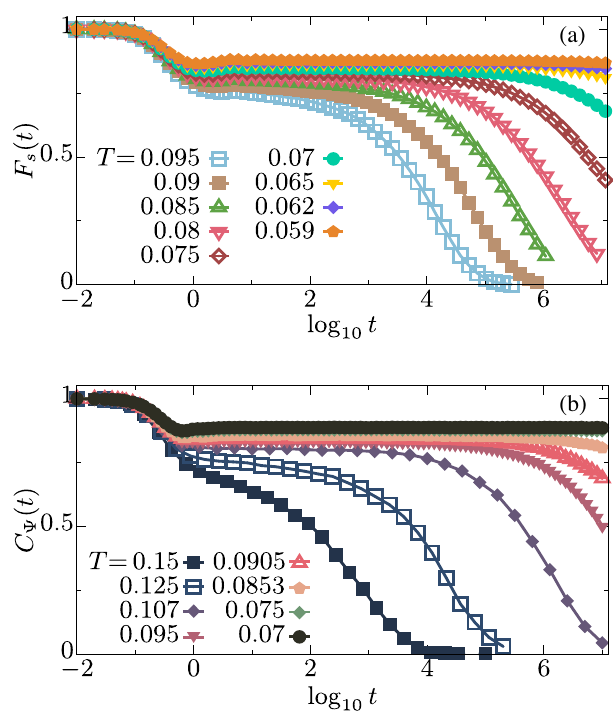
FIG. 1. Equilibrium time correlation functions characterizing relaxation dynamics of deeply supercooled liquids. (a) Self- intermediate scattering function F in 3D. (b) Bond-orientational s correlation function C Ψ in 2D. In both panels, we show only temperatures between the mode-coupling crossover and the ≤ T ≤ T experimental glass transition temperature, T g MCT